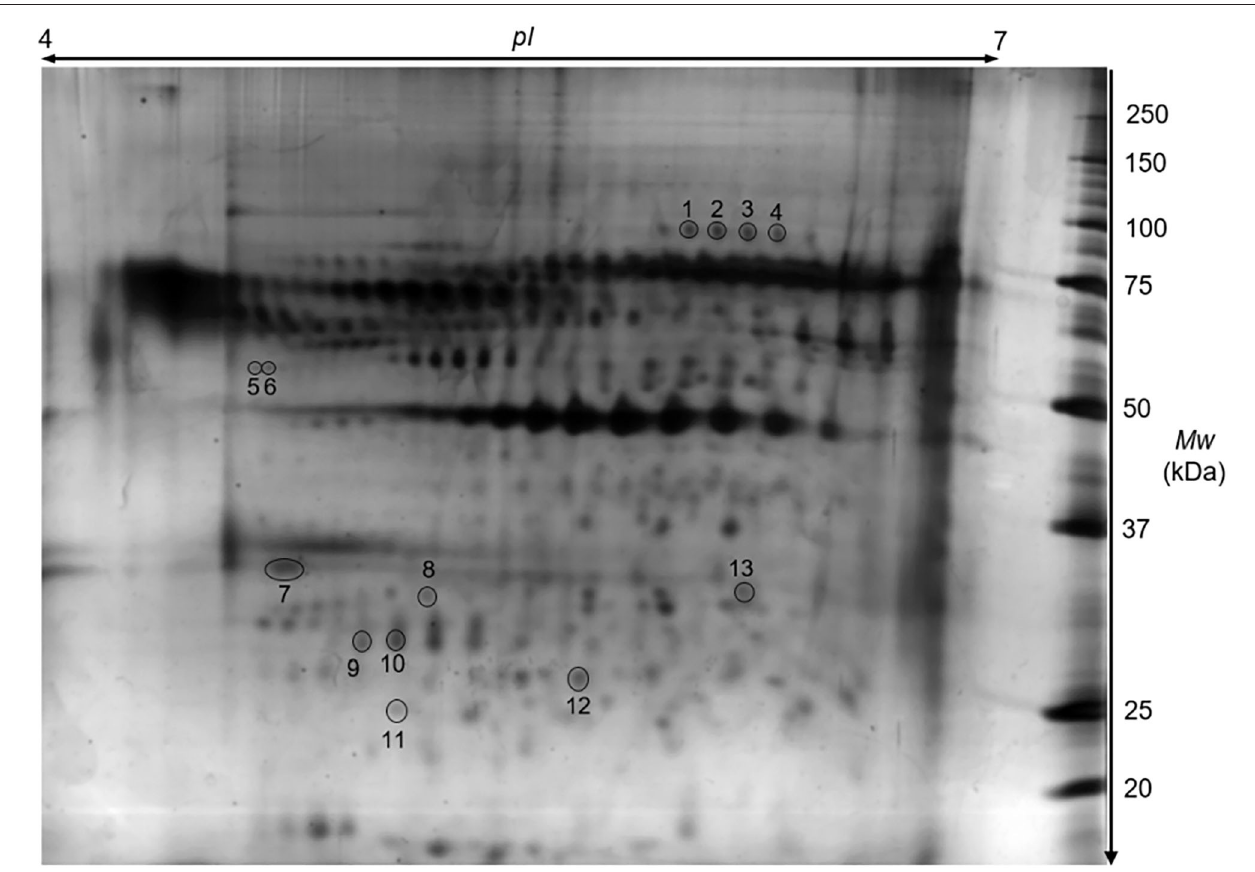
FIGURE 4 | A representative proteomic 2D map of splenic CD4 + T cells. The 2-DE gel illustrates a Coomassie-stained protein pattern. Spot numbers correspond to the numbers in Table 4